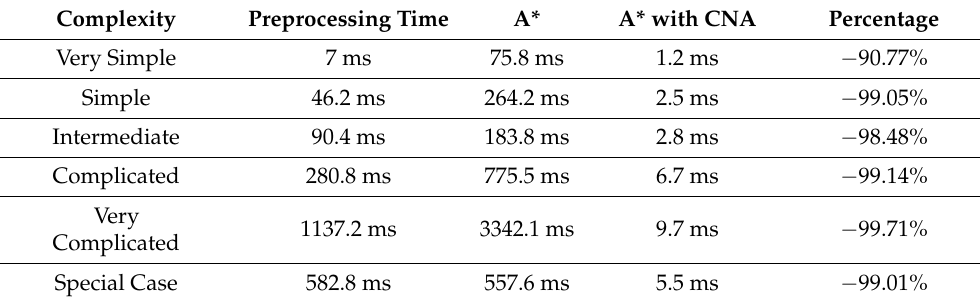
Table 5. Experimental